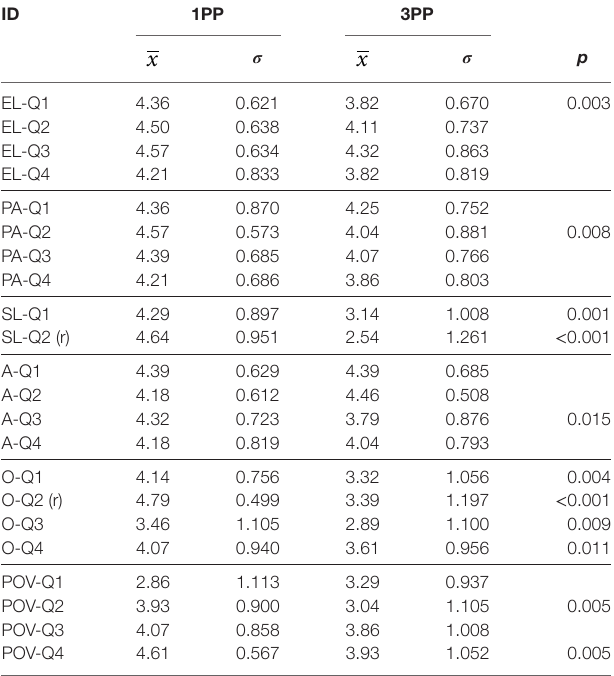
TaBle 2 | Statistical summary of the answers to the post experiment questionnaire presenting each factor of the three dimensions: spatial presence iD